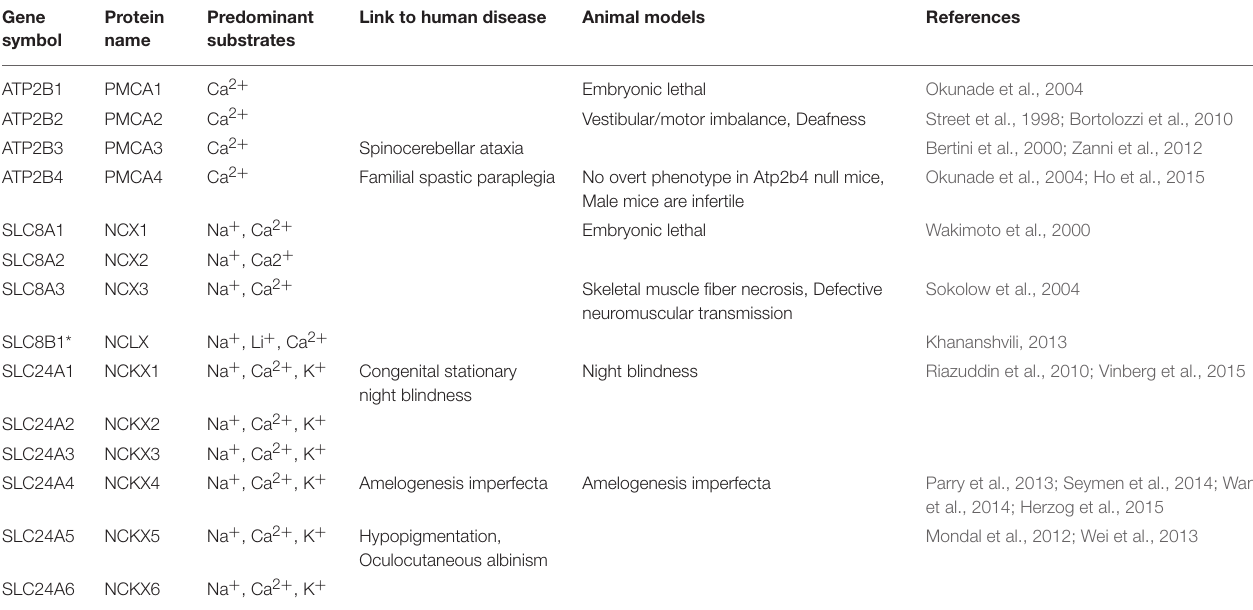
TABLE 1 | Pathologies associated with genes ATP2B1-4, SLC8A1-3 and